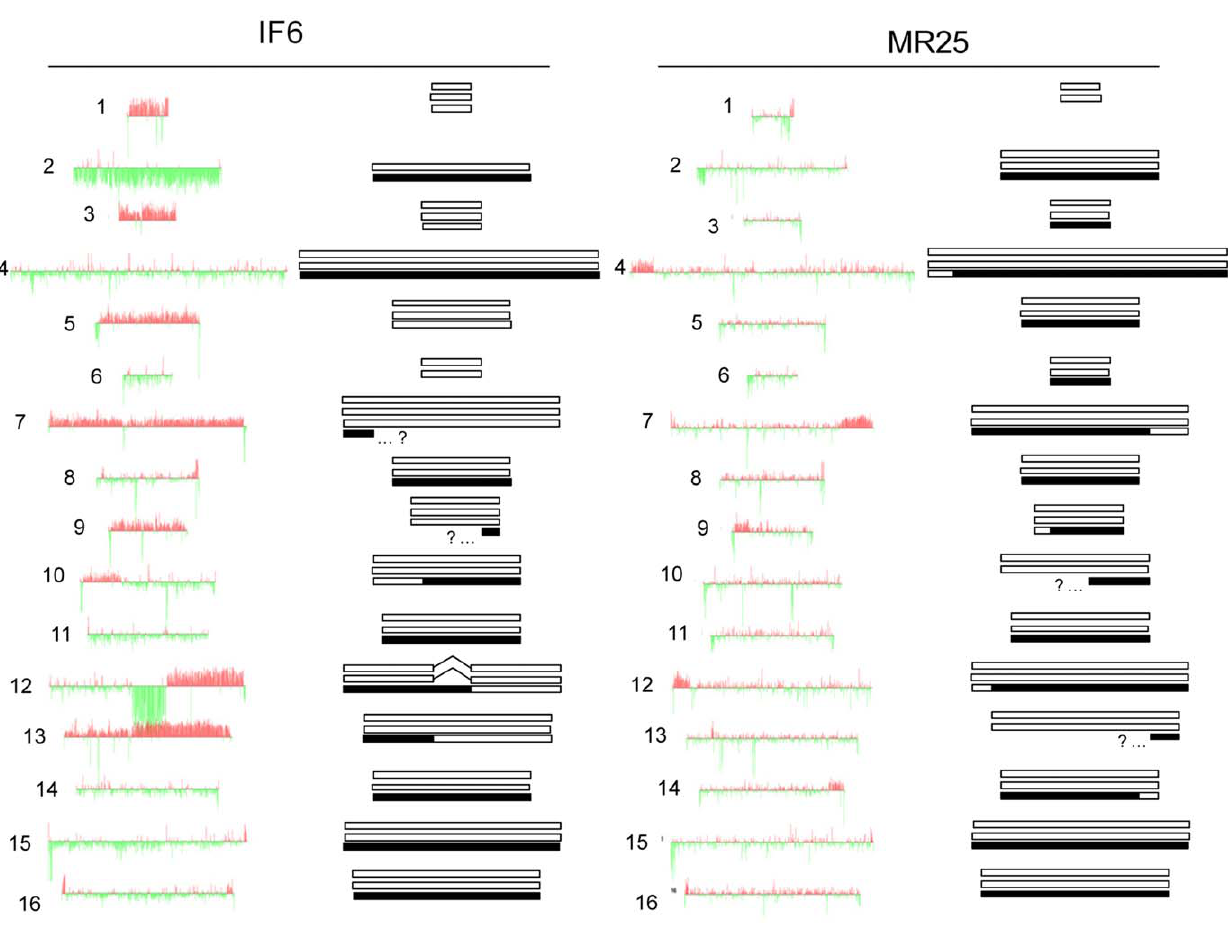
Figure 3. Genome composition of hybrid strains IF6 and MR25 obtained by combining aCGH (this work) and PCR-RFLP [ 17 ] analyses. Red and green signals correspond to the hybrid strain and the reference strain (S288c), respectively. White and black bars are used to represent S. cerevisiae and S. kudriavzevii fractions, respectively. Chromosomes showing black and white sections correspond to chimerical chromosomes. As an example, chromosome XIV in MR25 displayed a double RFLP pattern for EGT2 , corresponding to the S. cerevisiae and S. kudriavzevii alleles, and one single pattern for BRE5 , matching the S. cerevisiae allele restriction pattern [17]. The chimerical nature of this chromosome is confirmed by the caryoscope diagram where two different log 2 ratios are observed, indicating a different S. cerevisiae chromosome content. By combining both sources of information, we can deduce that most chromosome XIV corresponds to two copies of S. cerevisiae (according to the EGT2 RFLP pattern and aCGH data) and one of S. kudriavzevii (according to EGT2 RFLP pattern), but chromosome XIV right end corresponds to three copies of S. cerevisiae (according to BRE5 RFLP pattern and aCGH data). The recombination site in the chimerical chromosome can be located according to the log 2 ratio jump observed in the caryoscope diagram.